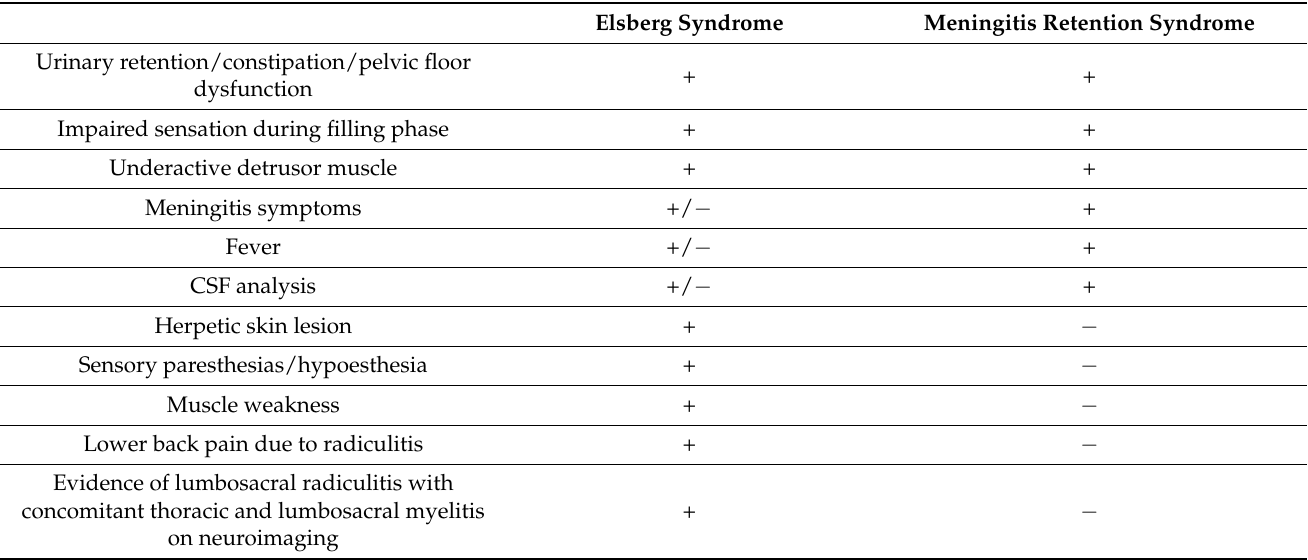
Table 2. Comparison table of Elsberg syndrome and meningitis retention syndrome presentations [40,42]. Elsberg